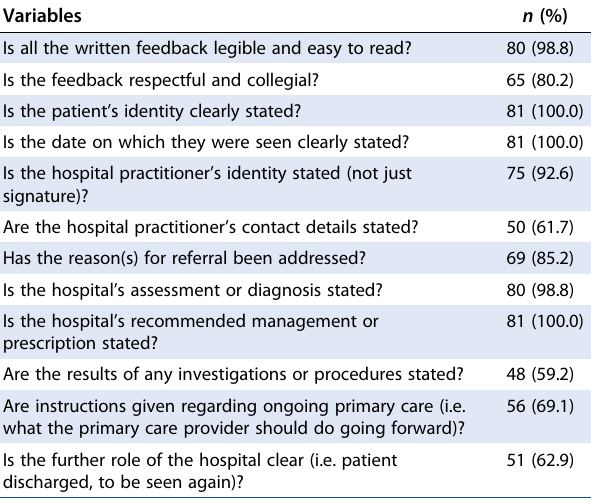
Table 4 categorises patients ’ feedback on their experience of being referred at the primary care facility. Most patients